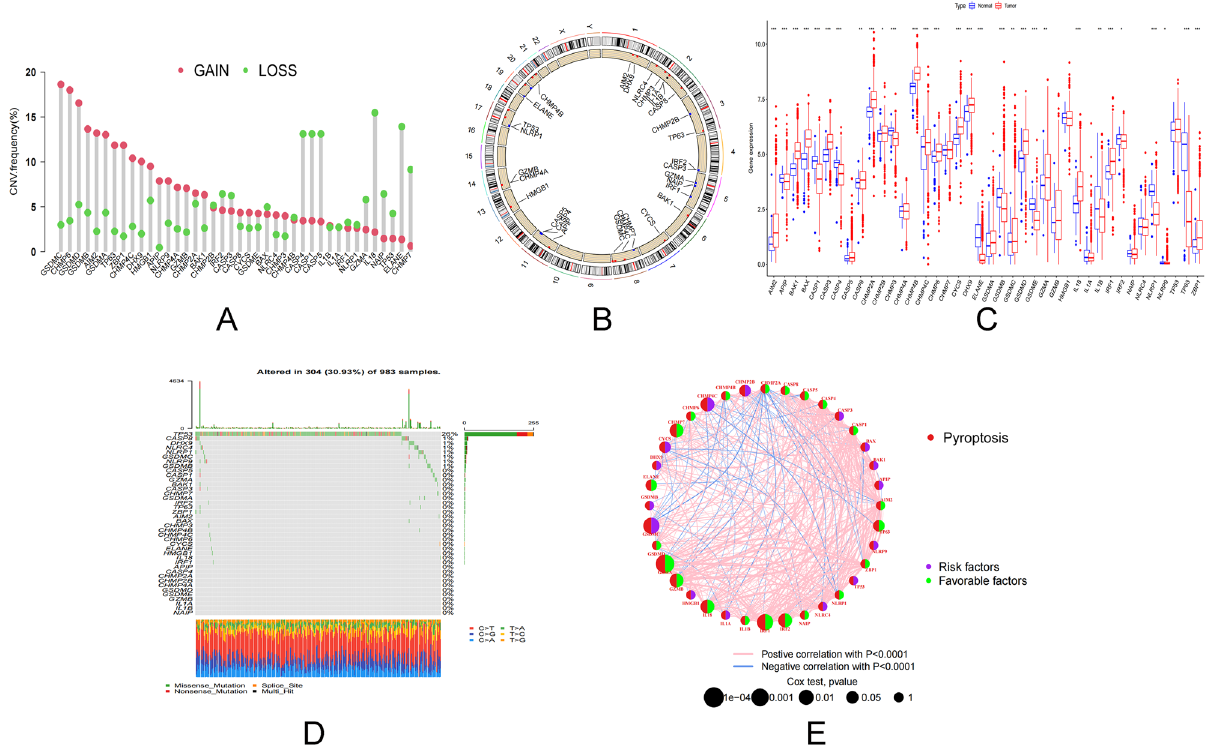
Figure 1. Transcriptional and genetic alterations of PRGs in BC. ( A ) Frequency of CNV gain, loss and non- CNV with PRGs. ( B ) Location of CNV alterations in PRGs on 23 chromosomes. ( C ) Distribution of 40 PRGs expression in normal and BC tissues. ( D ) Frequency of mutations in 40 PRGs in 1098 BC samples from the TCGA cohort. ( E ) Interaction between PRGs in BC. The lines connecting the PRGs represent their interactions and the thickness of the lines indicates the strength of the association between the PRGs. Green and pink represent negative and pink-positive associations, respectively. PRGs pyroptosis-associated genes, BC breast cancer, TCGA cancer genome atlas, CNV copy number